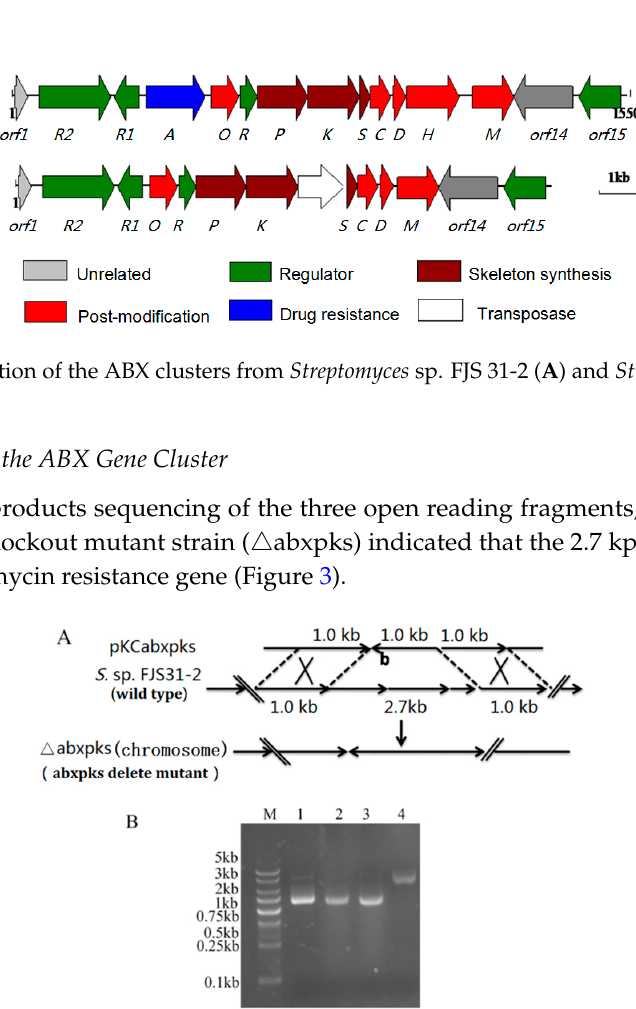
Figure 3. Deleted mutation of abxp, abxk, and abxs. ( A ) Mutation strategies of abxp, abxk, and abxs. ( B) Analysis of abxp, abxk, and abxs deletion by PCR (lanes 1, 2, and 3: abxpks-deleted mutants; lane 4: wild-type strain; and M: DNA marker).